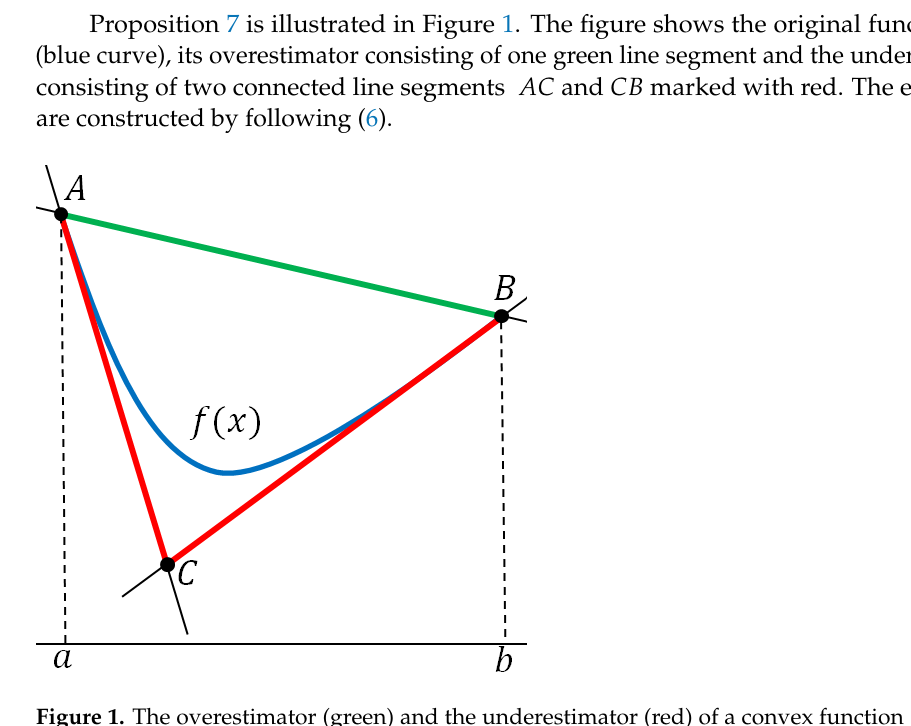
Figure 1. The overestimator (green) and the underestimator (red) of a convex function f ( x ) on an interval [ a , b ]